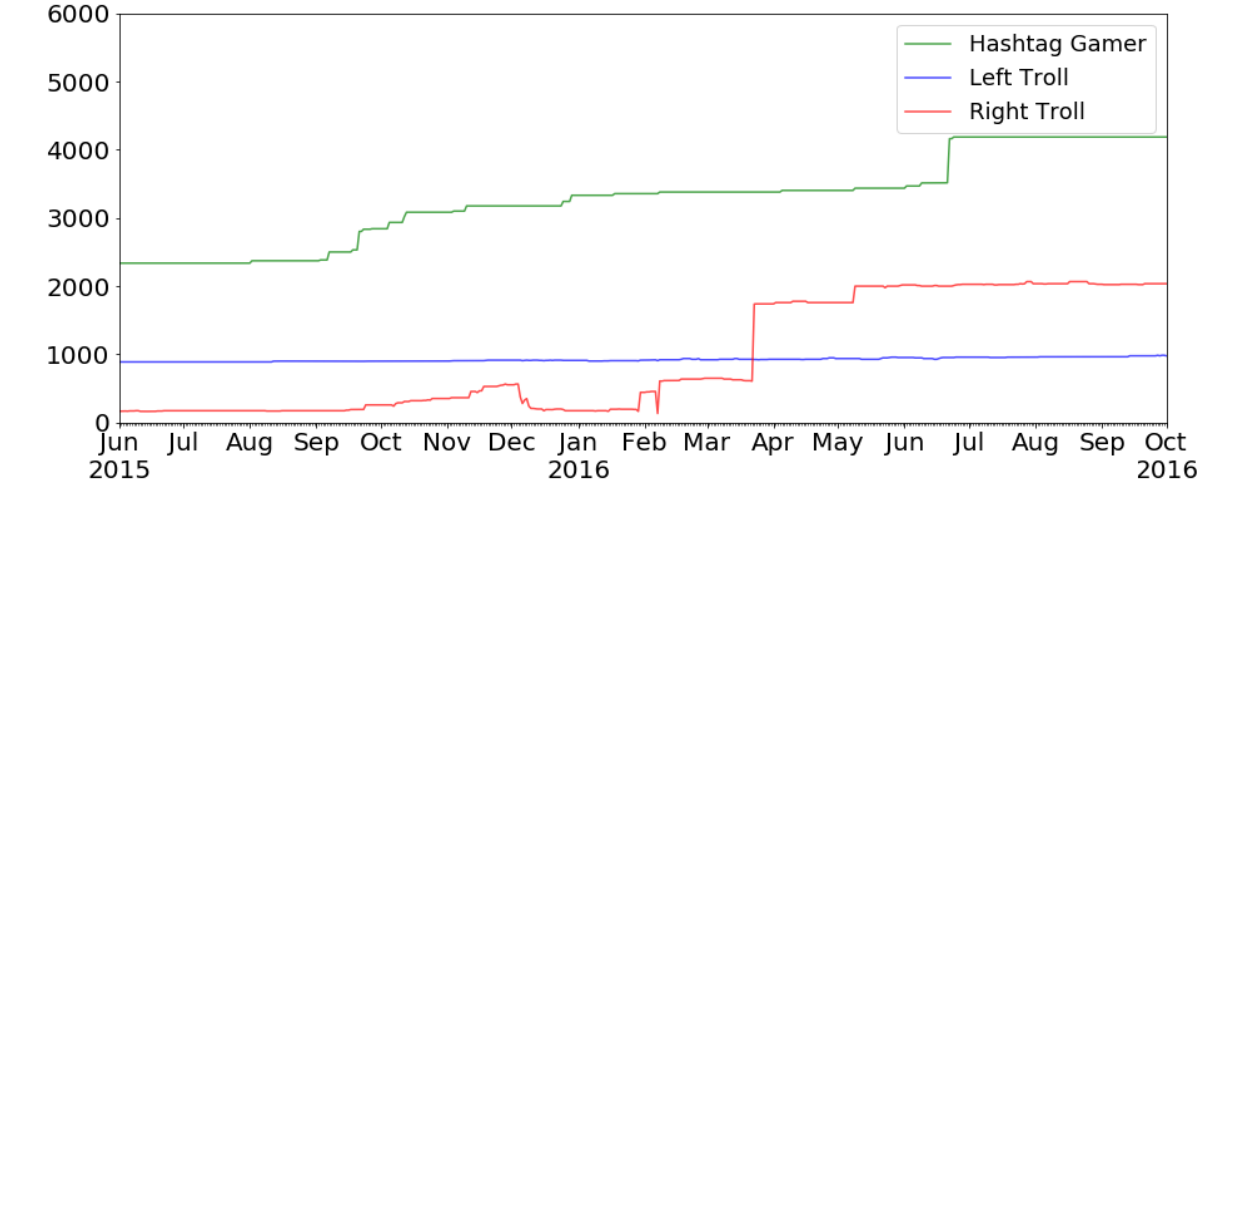
Appendix Figure 4. Approximate Median Followers for Active IRA Accounts of the Indicated